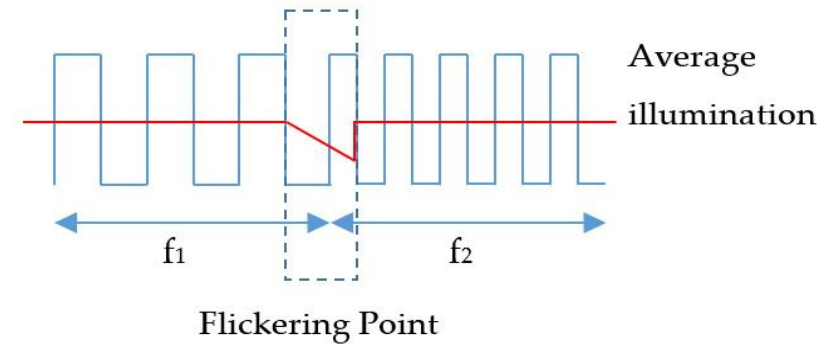
Figure 8. OOK signal at 2 kHz ( a ), 1 kHz ( b ), and 500 Hz ( c ).